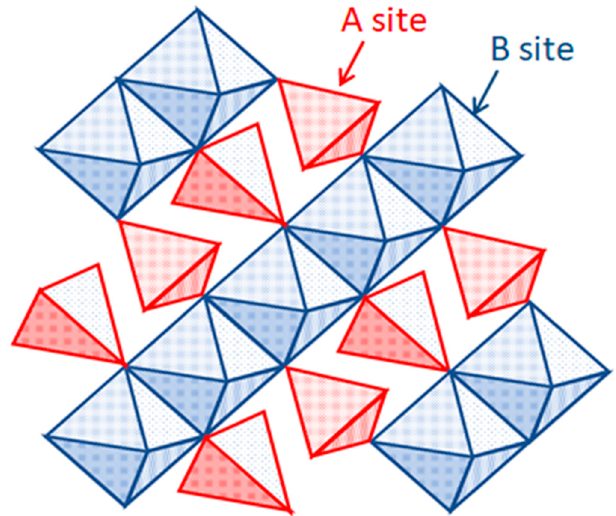
Figure 1. Spinel structure. Cations occupy the centre of tetrahedra (sites A) and octahedra (sites B). Oxygen anions are at the corner between two octahedra and one tetrahedron.